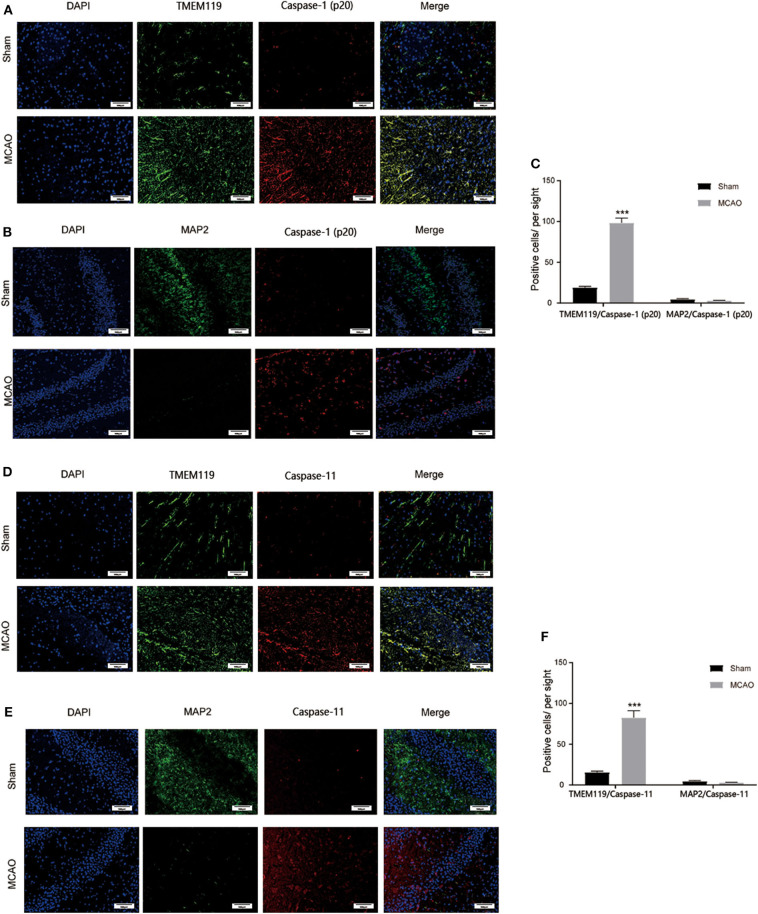
Main cell type for pyroptosis post I/R injury. (A) Caspase-1+ (red) and TMEM119+ (green) cells were significantly induced in the cortex at 24 h post I/R injury. (B) Caspase-1+ (red) cells were largely induced while MAP2+ (green) neurons were rarely detected in the cortex at 24 h post I/R injury. (C) Statistical analysis of immunofluorescence-positive cells. (D) Caspase-11+ (red) and TMEM119+ (green) cells were significantly induced in the cortex at 24 h post I/R injury. (E) Caspase-11+ (red) cells were largely induced while MAP2+ (green) stained neurons were rarely detected in the cortex at 24 h post I/R injury. (F) Statistical analysis of immunofluorescence-positive cells. Scale bars: 100 μm. n = 5. Data are presented as mean ± SD. ***P < 0.001, vs. the Sham group. I/R, ischemia reperfusion.